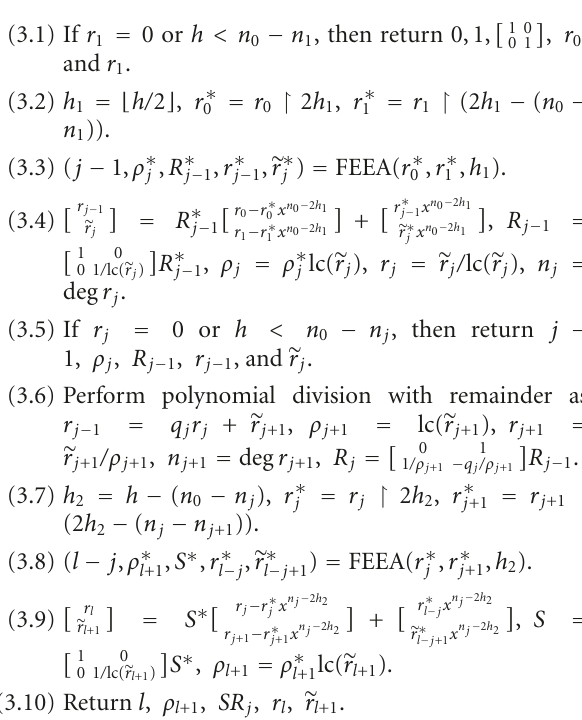
algorithm as well as Sch¨onhage and Strassen’s algorithm,